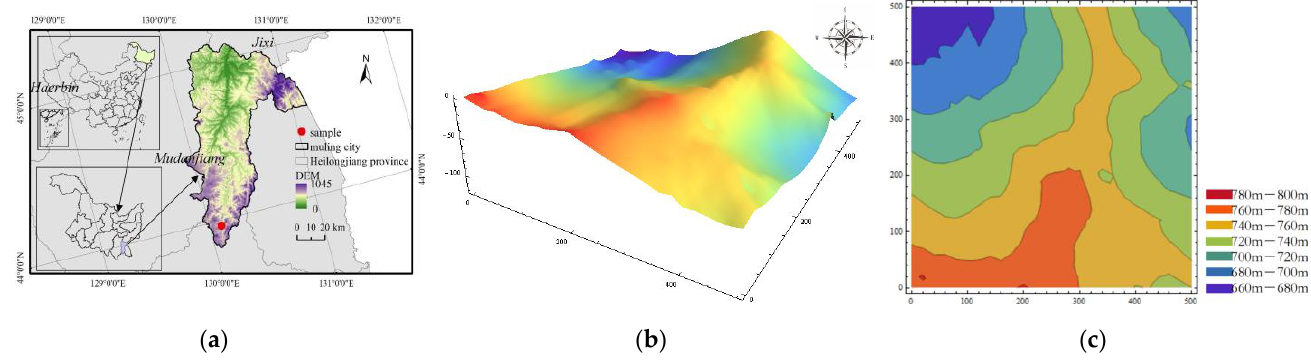
Figure 1. ( a ) Geographical location map of the study area; ( b ) 3D sample plot topographic map; ( c ) Sample plot contour map. ( b , c ) use the same color scale.